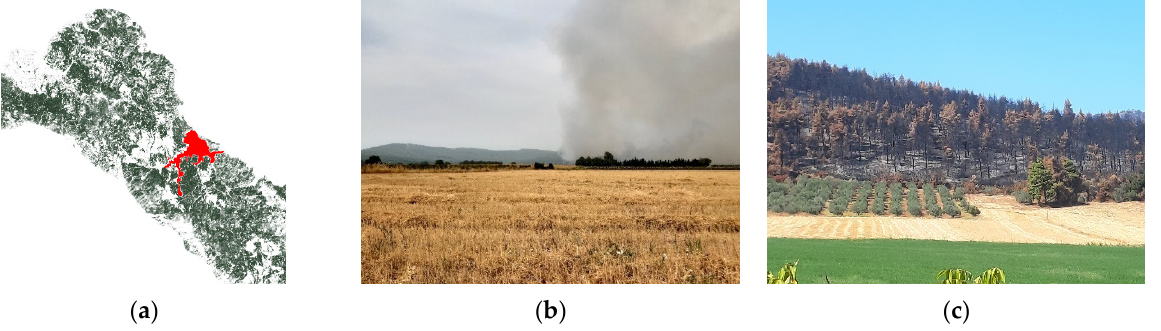
Figure 18. ( a ) The flatland of Krya Vrisi. ( b ) The flatland of Krya Vrisi during the fire. ( c ) The flatland of Krya Vrisi after the fire.